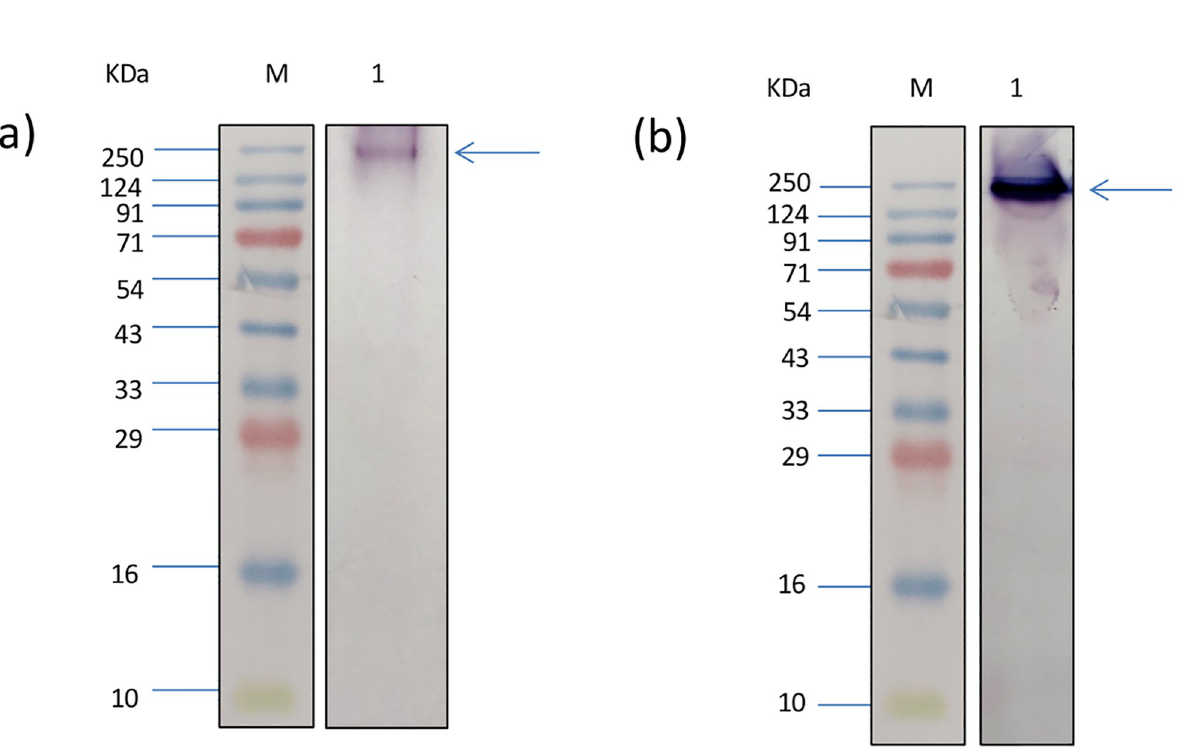
Fig 3. A single band of about 250 kDa was obtained when the whole homogenate of F . gigantica ( a) and mitochondrial fraction (b) were subjected to zymography using Tyramine-HCl and Nitroblue tetrazolium. M: standard molecular weight marker.